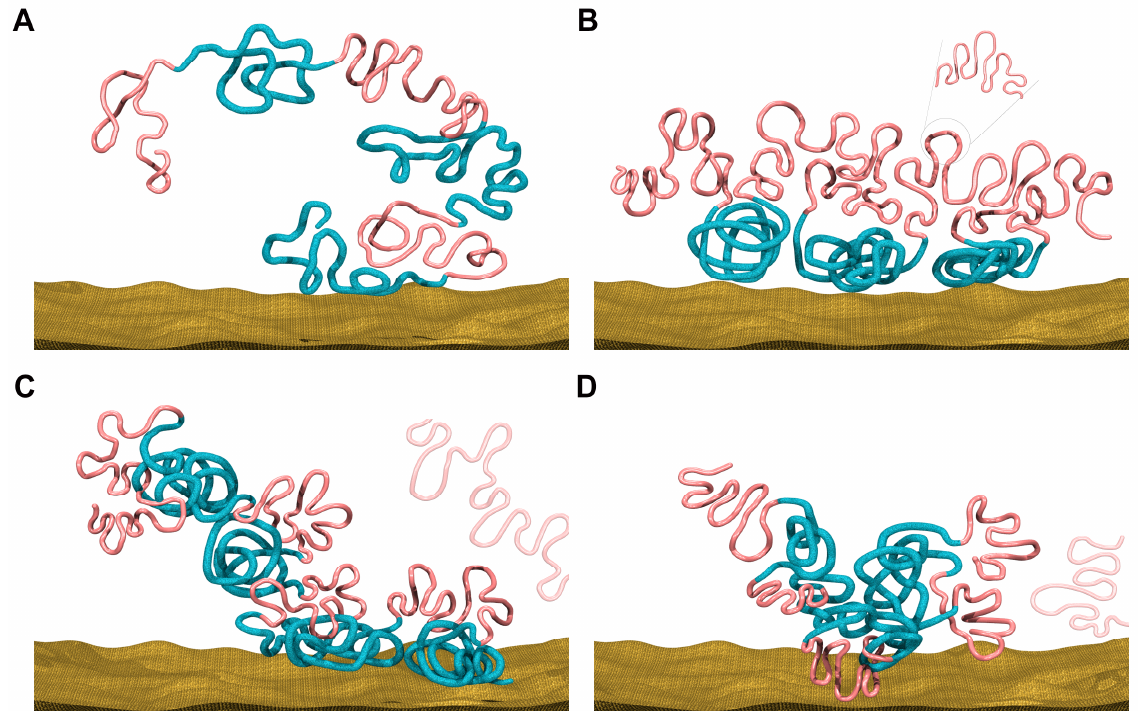
Figure 6. Schematic pictures of chromatin structural patterns at different stages. ( A ) In the beginning zygotic stage, chromatin has few long-range structural features. Here, the red lines represent CGI forest domains, and the blue ones represent CGI prairie domains. ( B ) In ICM stage, the two different types of domains segregate from each other to form compartments. ( C ) In differentiated cells, prairies containing tissue-specific genes tend to form contacts with forests. ( D ) During senescence, prairies congregate further (with an increased probability to detach from the nuclear membrane).